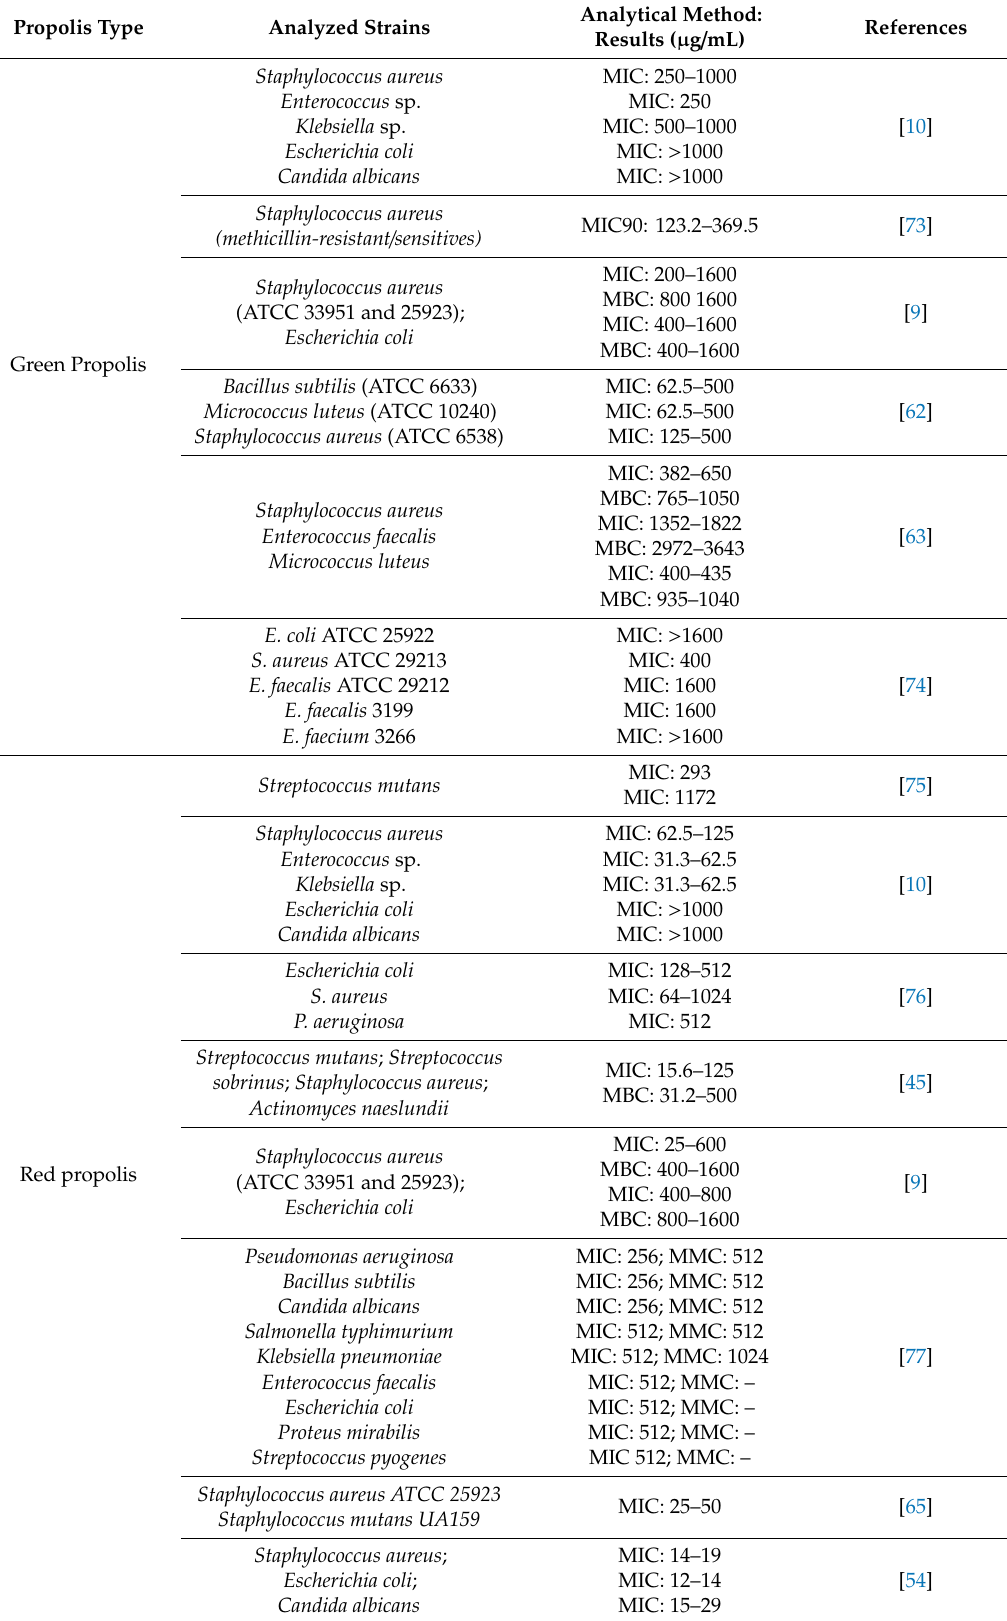
Table 2. Antibacterial and antifungal activity of red and green Brazilian propolis. Propolis